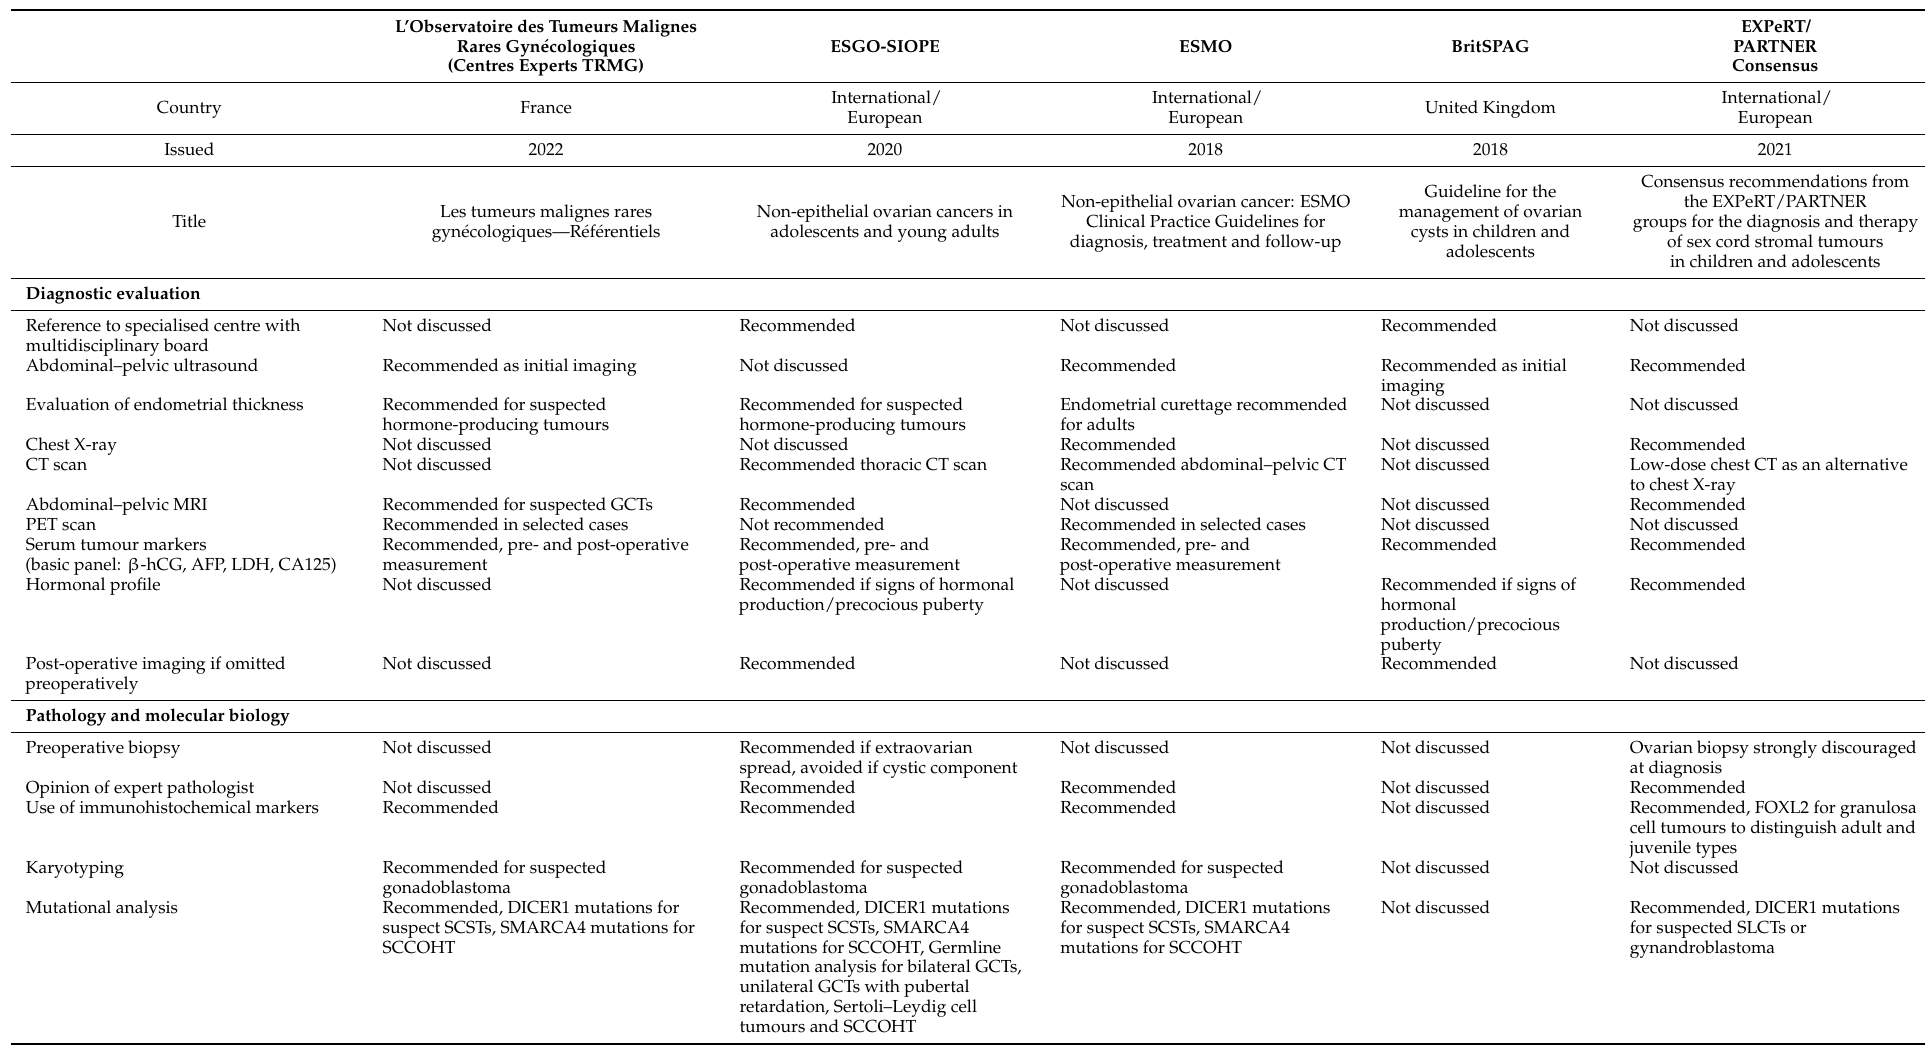
Table 2. Summary of